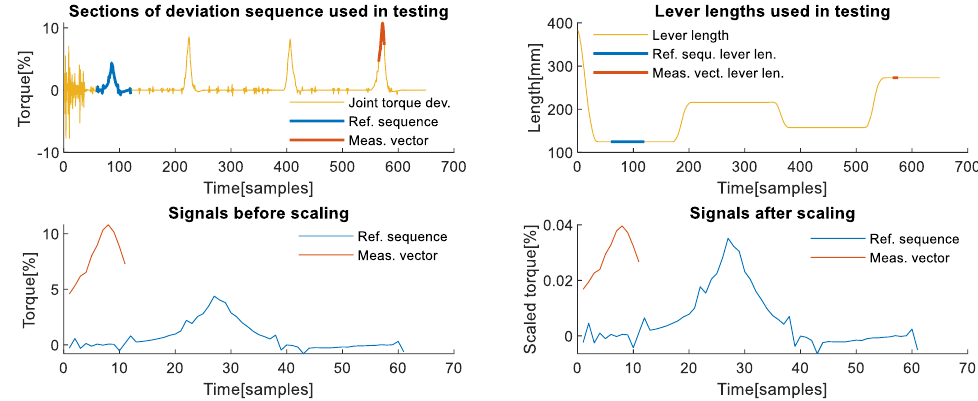
Figure 7. Signals obtained during snap-fit assembly task from the 1st axis. ( left ) Measurements of joint torques while the robot was performing the task without and with assembly of the object. The difference between them corresponds to the profile of the contact-task-induced deviation. ( right ) Measurement of the joint angle used to calculate equivalent lever lengths. Similar to previous examples, Figure 8 in the upper left part shows sections of the devi- ation sequence, shown in yellow, which were used as reference sequence and measurement vector, highlighted in blue and red, respectively. The same is valid for lever lengths on the upper right graph of the same figure. From the lower left part of Figure 8, it is possible to observe that the selected reference sequence shown in blue and the measurement vector shown in red are similar only in shape but not in scale and values, although they originate from the same task. Scaling, which is an integral part of the KA-mDTW algorithm, makes these signals much easier to compare and interpret, as shown in the lower right part of Figure 9.